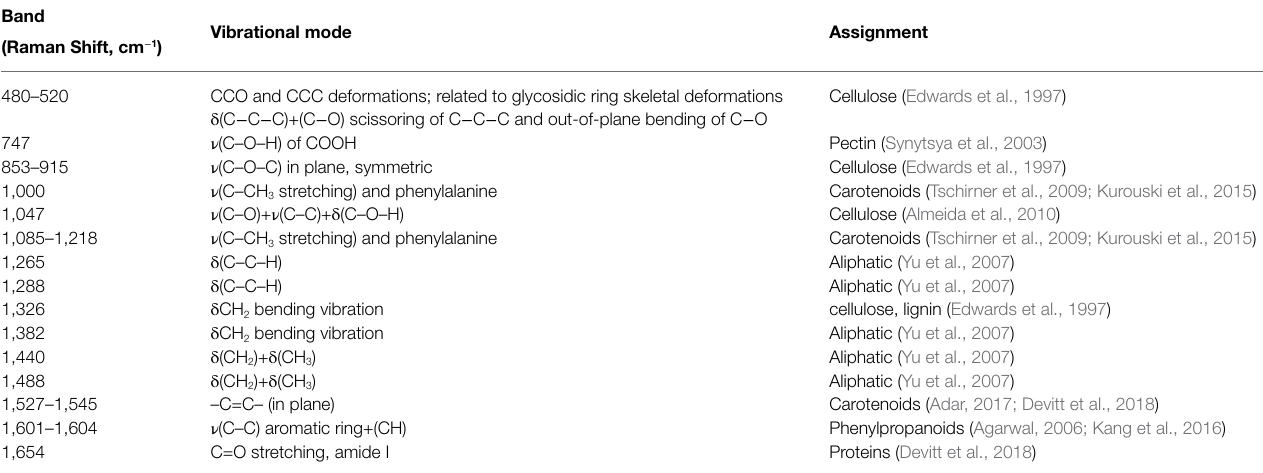
TABLE 2 | Vibrational bands and their assignments for Raman spectra collected from banana plants. Band (Raman Shift, cm − 1